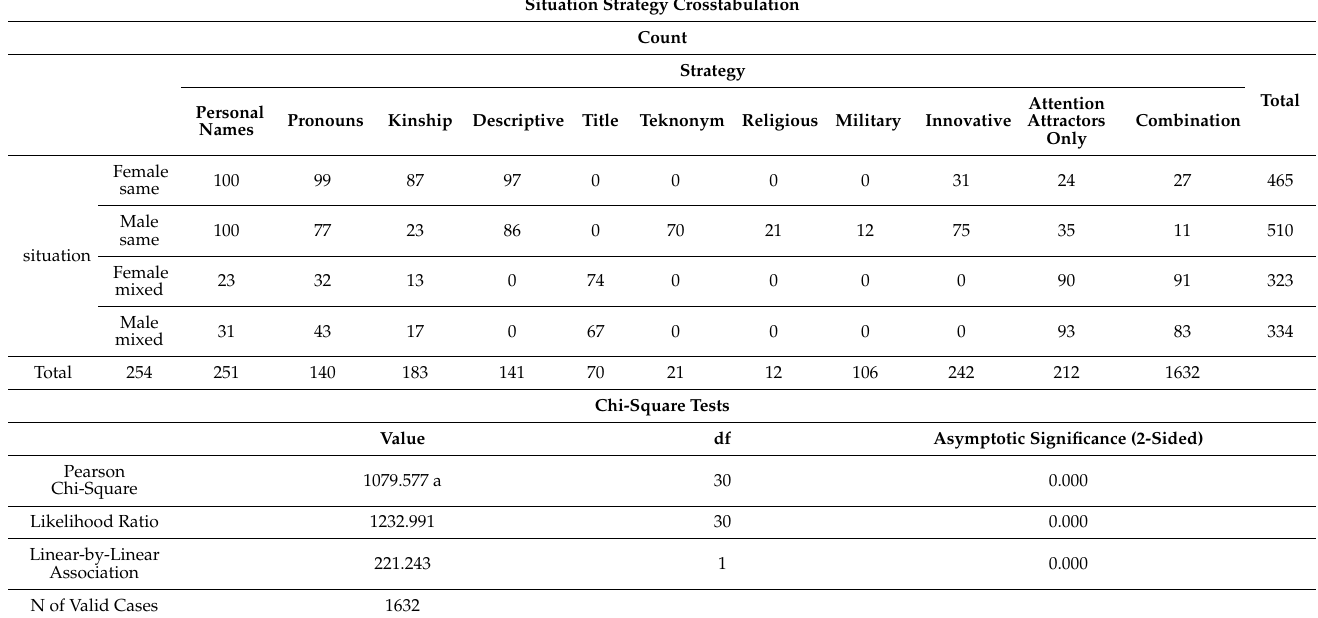
Table 3. Chi-square results of the key address terms used in same-gender and mixed-gender